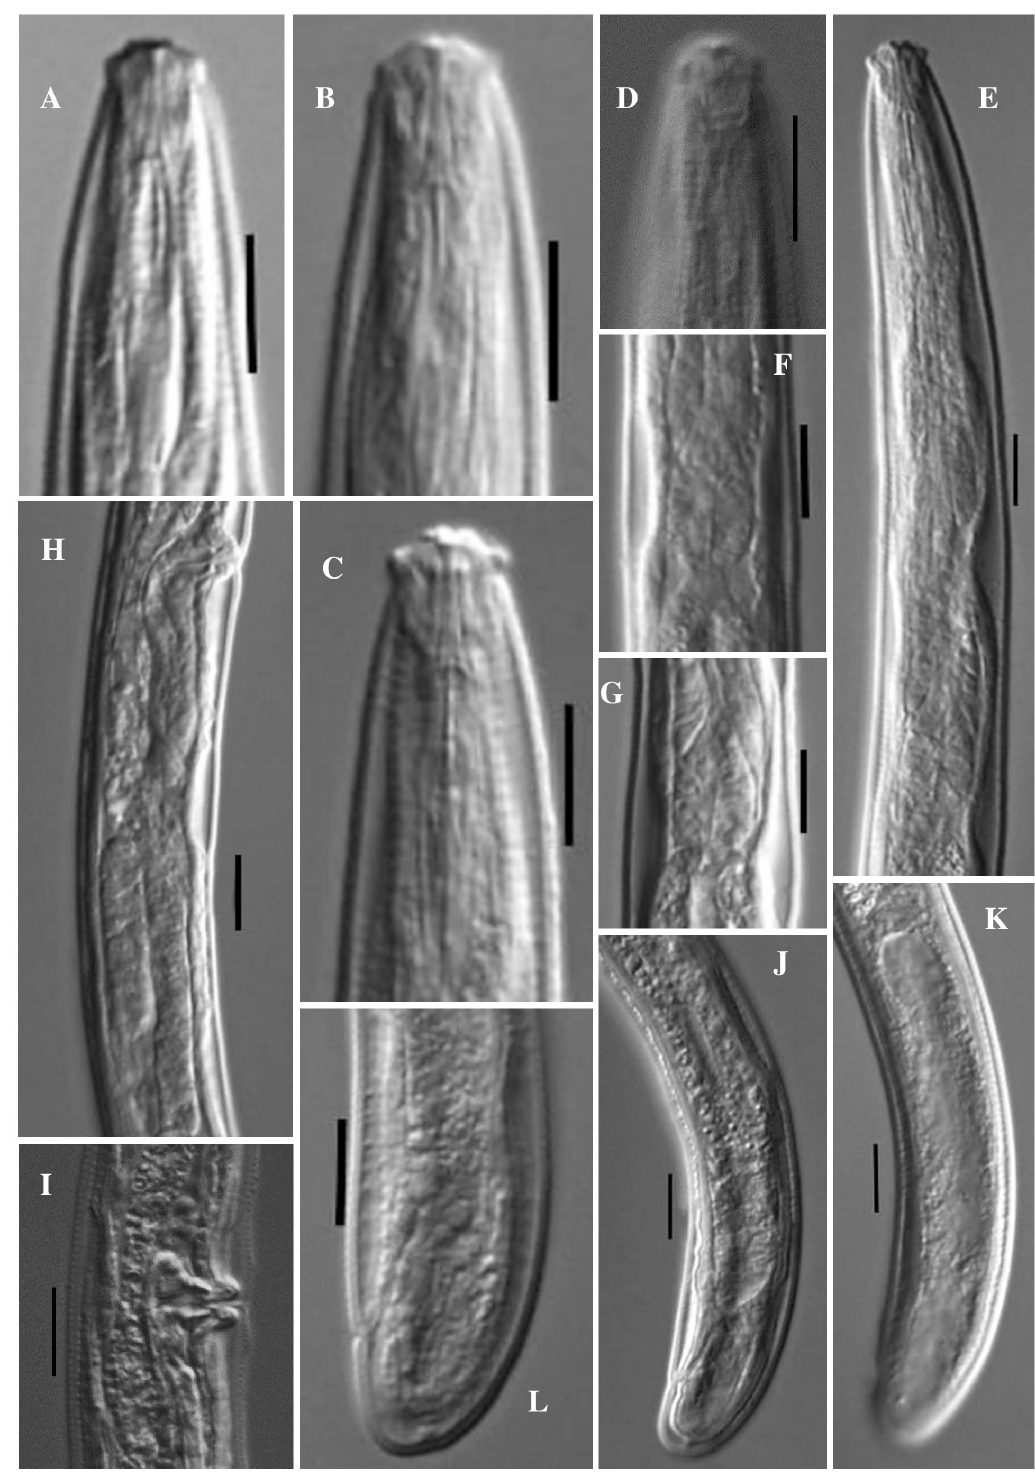
Fig. 5. Basirotyleptus acus Goseco, Ferris & Ferris, 1974, ♀ (AMU/ZD/NC/ Basirotyleptus acus /1–4) (LM photographs). A–C . Anterior region. D . Anterior region showing amphid. E . Pharyngeal region. F–G . Pharyngeal bulb. H . Genital system. I . Vulval region. J–K . Posterior region. L . Posterior end. Scale bars = 10